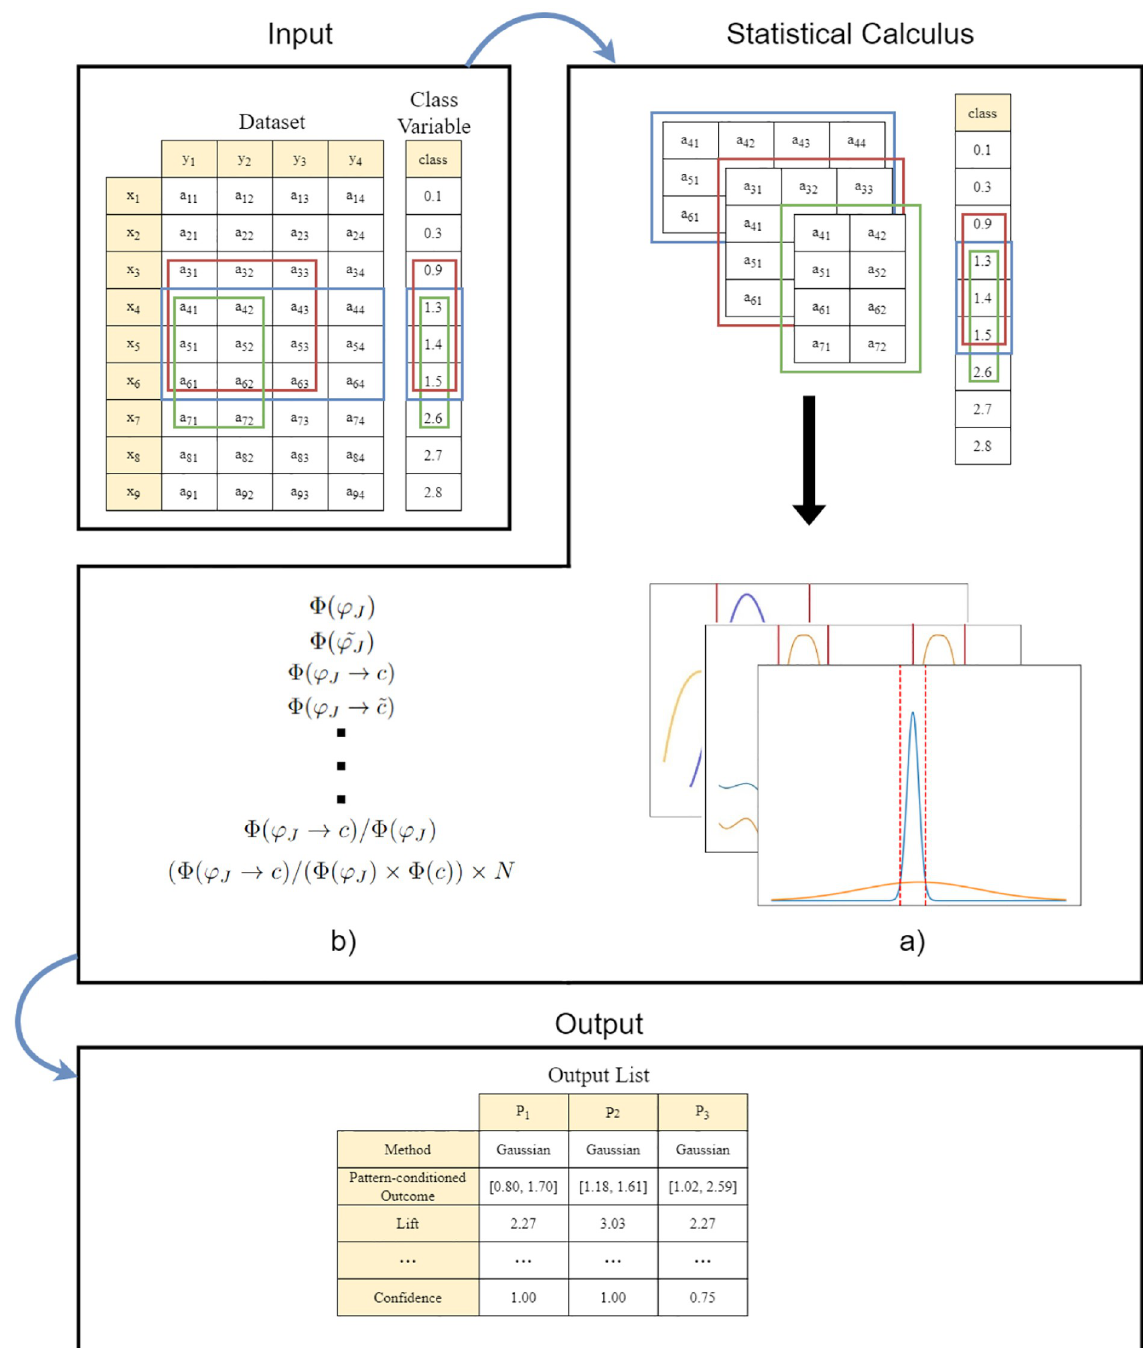
Fig 6. Overview of DISA workflow. Input: multivariate data (optional); list of patterns; and outcome variable. Statistical calculus: a) discriminated ranges from pdf (probability density function) intersection points (numerical outcomes only) and b) pattern properties, and metrics (e.g. statistical significance, gini index, information gain). Output: list of metrics per pattern.